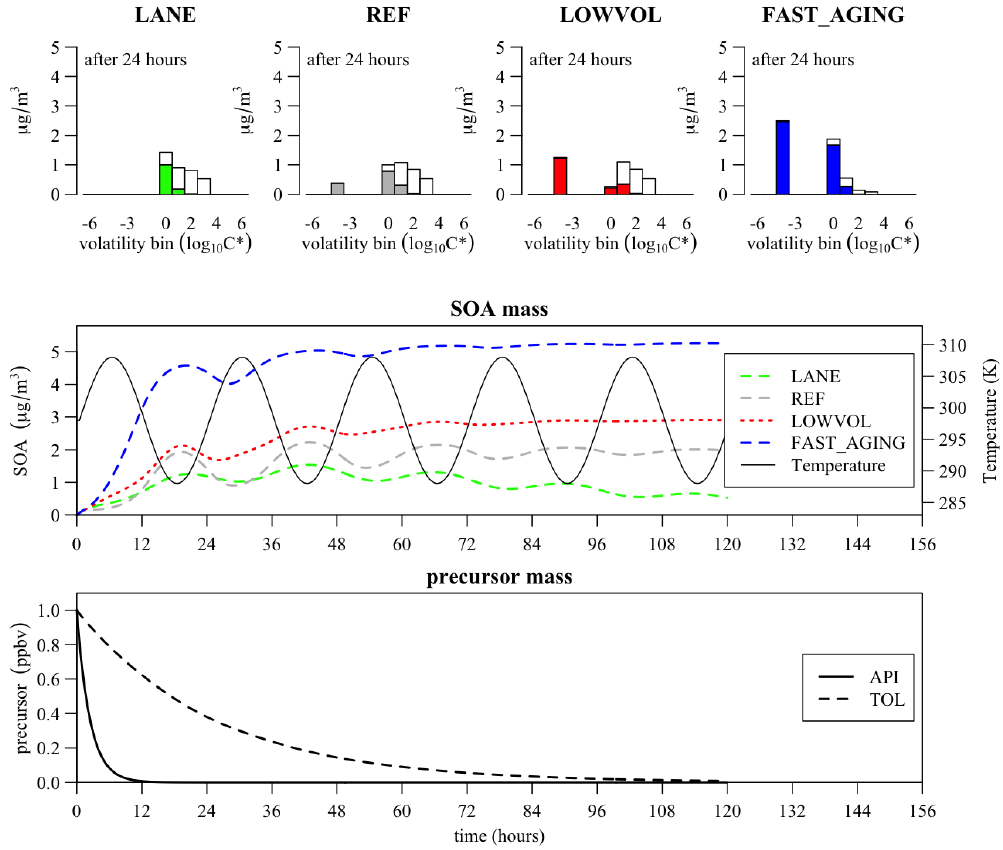
Figure A1. Box-model simulations of the oxidation of 1ppbv α -pinene and toluene. Top row: distribution of particulate (colored) and vapor mass (white) in the different volatility bins after 24h. Second row: total particle mass of SOA formed, as well as temperature. Third row: time evolution of precursor